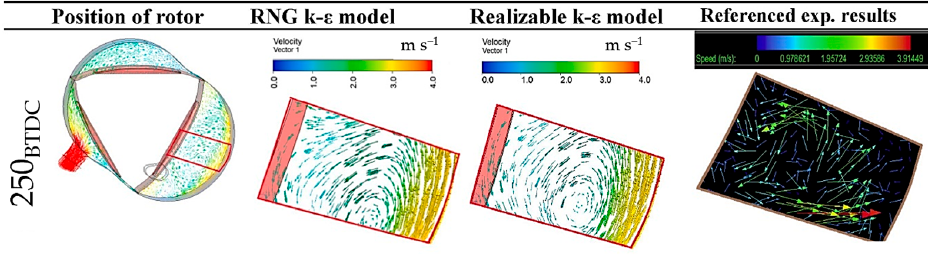
Figure 15. Comparison of RNG and Realizable k- ε models (Taskiran et al. [125]) . Hsieh and Cheng [85] , in their research, conducted a 3D simulation of an RE by set- ting the inlet pressure to 2 atmospheric pressure and outlet pressure to 1 atmospheric pressure while the rotation speed was 1800 rpm. It considered a turbulent model (k- ε model) and a clearance constant of 0.15 mm for apex sealing, and captured stream lines and vortex formation for three different chamber designs based on K factors (case1 = 10, case2 = 7.5, case3 = 6), as shown in Figure 16.